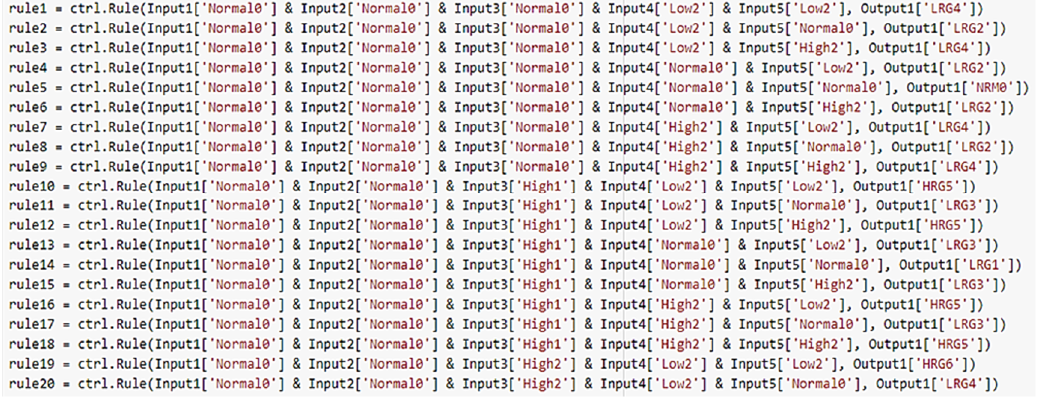
Figure 9. Fuzzy rules in